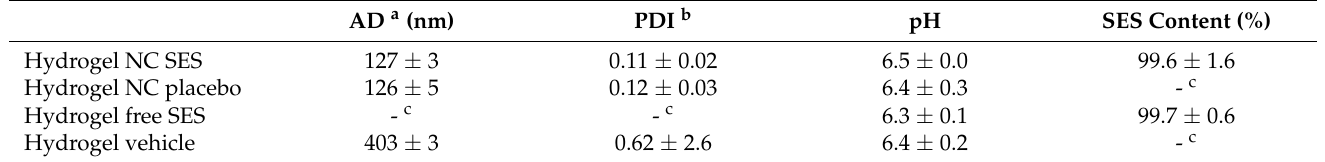
Table 2. Characterization parameters of the